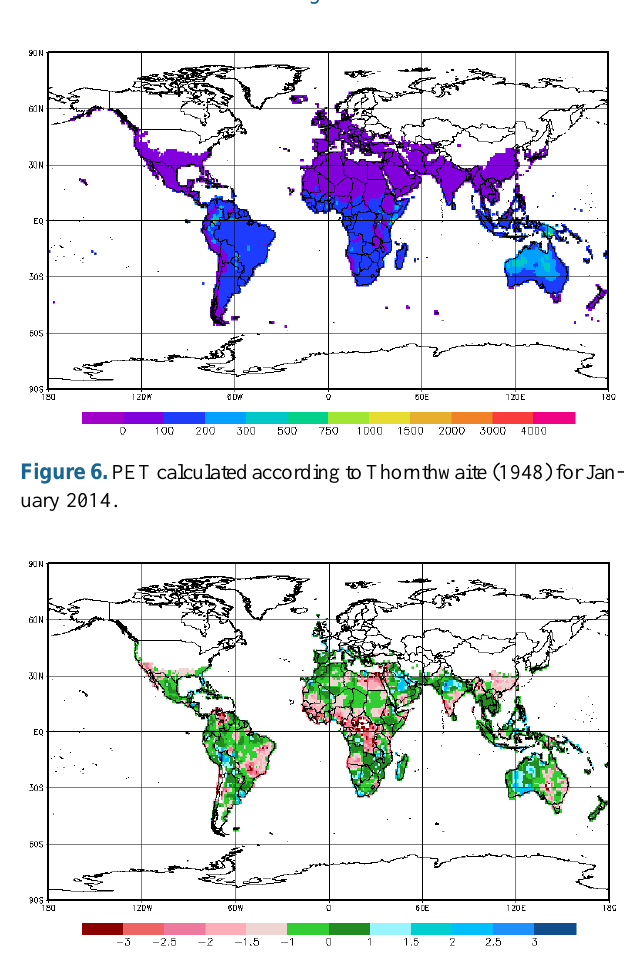
Figure 7. The SPEI with 1-month accumulation interval for Jan- uary 2014. The color scale is the same as in Fig. 3.